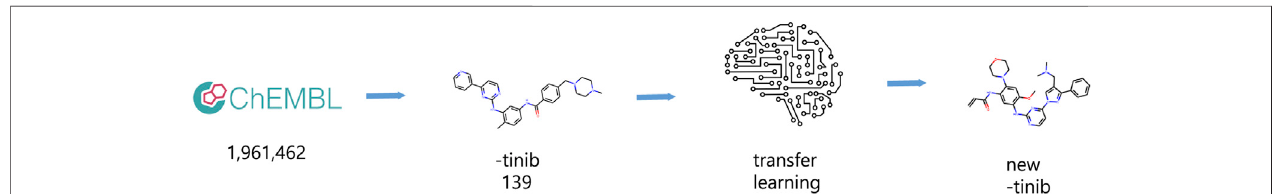
FIGURE 1 | Overall process. Data preparation and generative model